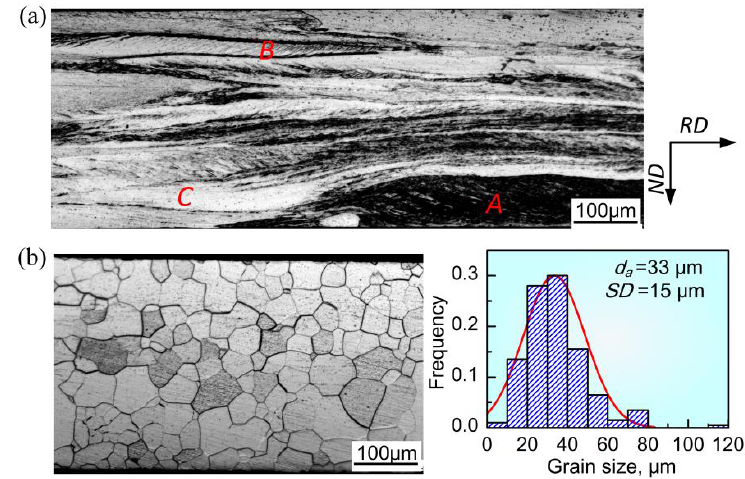
Figure 3. Optical microstructure of sheets processed by one-stage cold rolling. ( a ) cold-rolled sheet and ( b ) final annealed sheet.